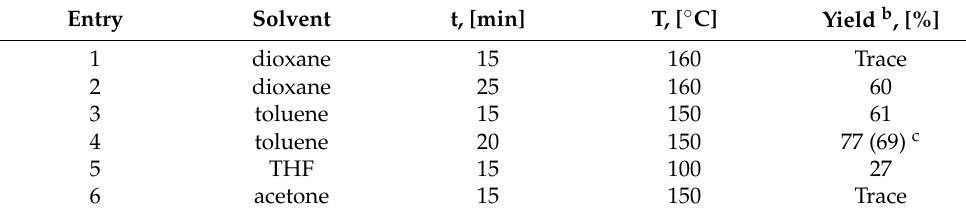
Table 5. Effect of various solvents on the synthesis of 15 under microwave conditions a .